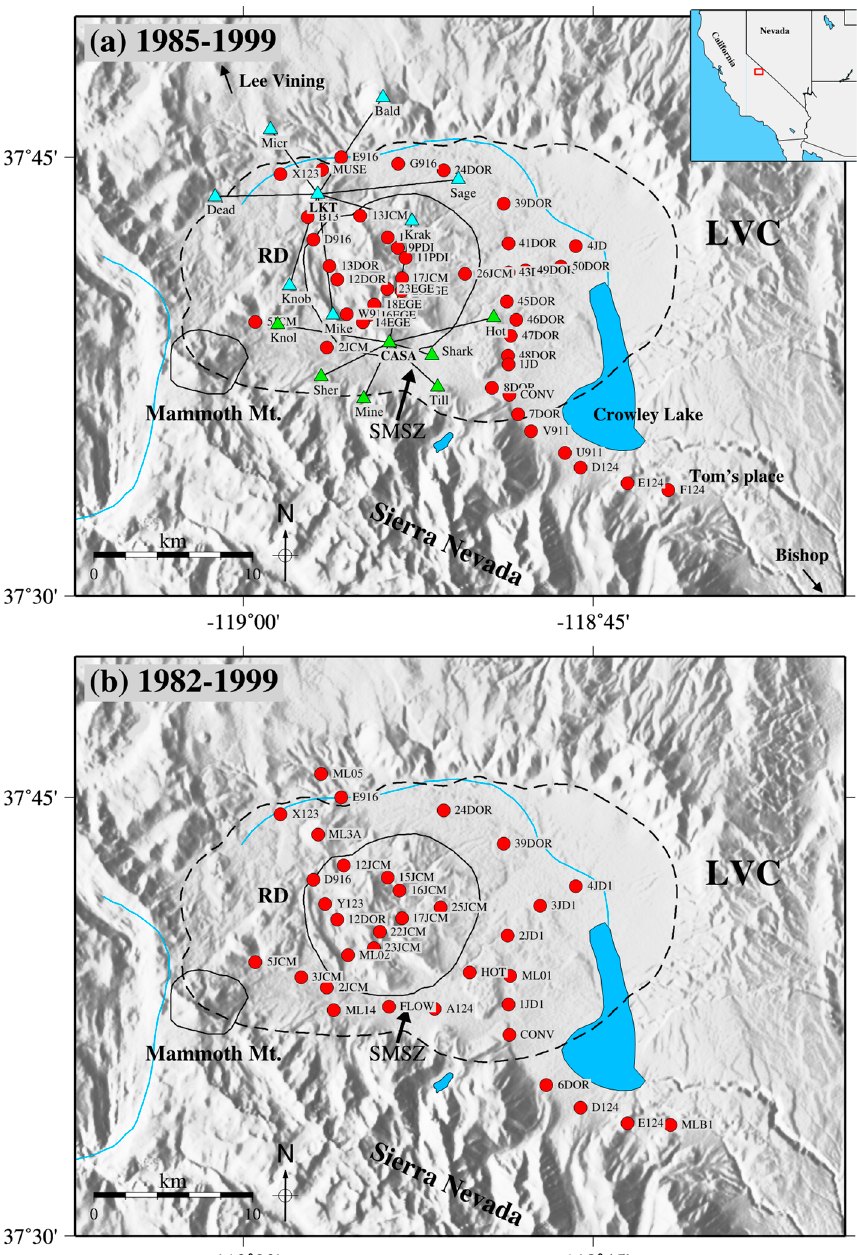
Figure 1. Map of Long Valley Caldera (LVC) and geodetic monitoring networks. Solid black lines represent the area of Resurgent Dome (RD) and Mammoth Mountain. Black dashed line outlines the LVC area. ( a ) Sites occupied in 1985–1999. Red circles are leveling stations. Green and cyan triangles refer to EDM baselines referred to common end-points CASA and LKT, respectively. ( b ) Sites occupied in 1982–1999. Red circles are leveling stations. No EDM data are available in this period.